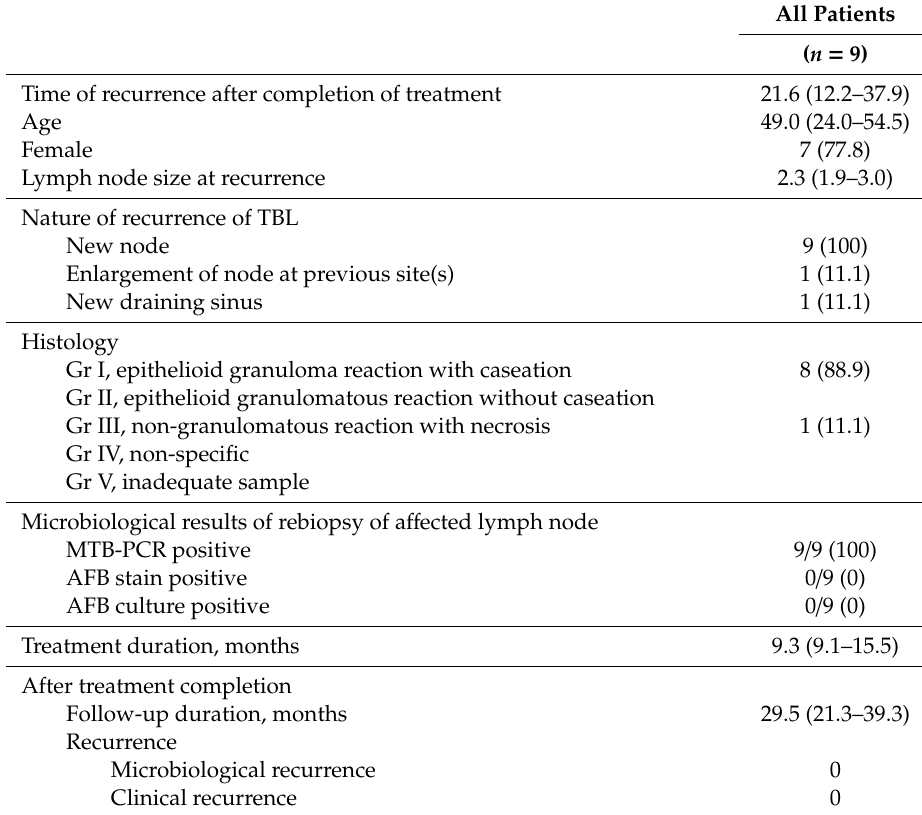
Table 3. Clinical characteristics and outcomes of the nine patients with TBL